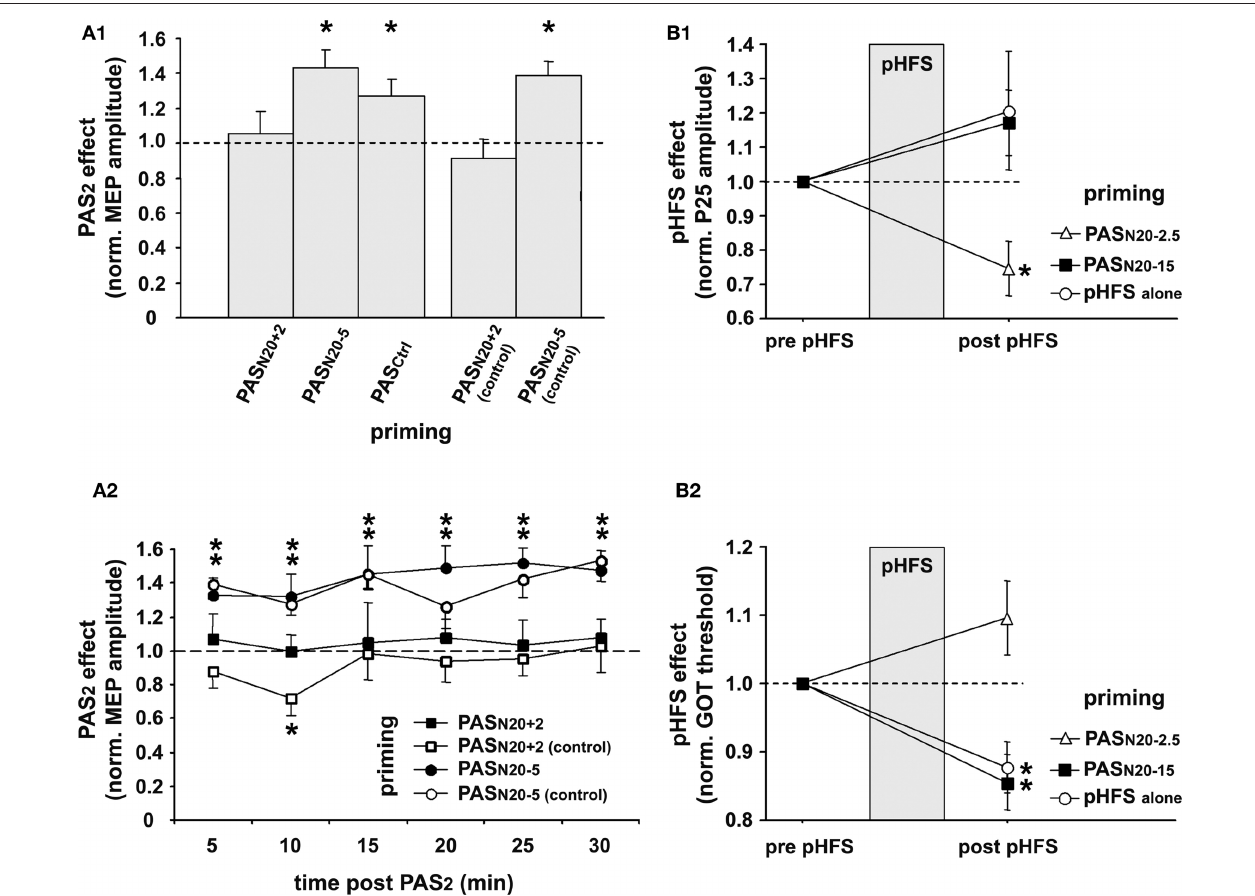
Figure 3 | Homeostatic metaplasticity governs timing dependent LTP-like plasticity in human primary motor (M1) and somatosensory (S1) cortex. (A) Homeostatic metaplasticity in M1. (A1) PAS was used to induce timing dependent LTP-like plasticity